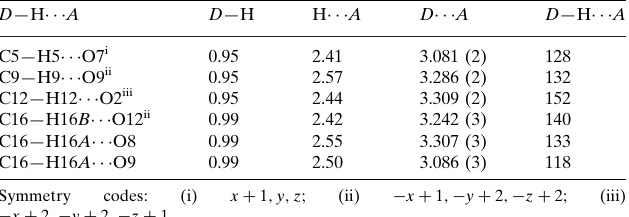
Hydrogen-bond geometry (A˚ , (cid:3) ). D —H (cid:2)(cid:2)(cid:2)